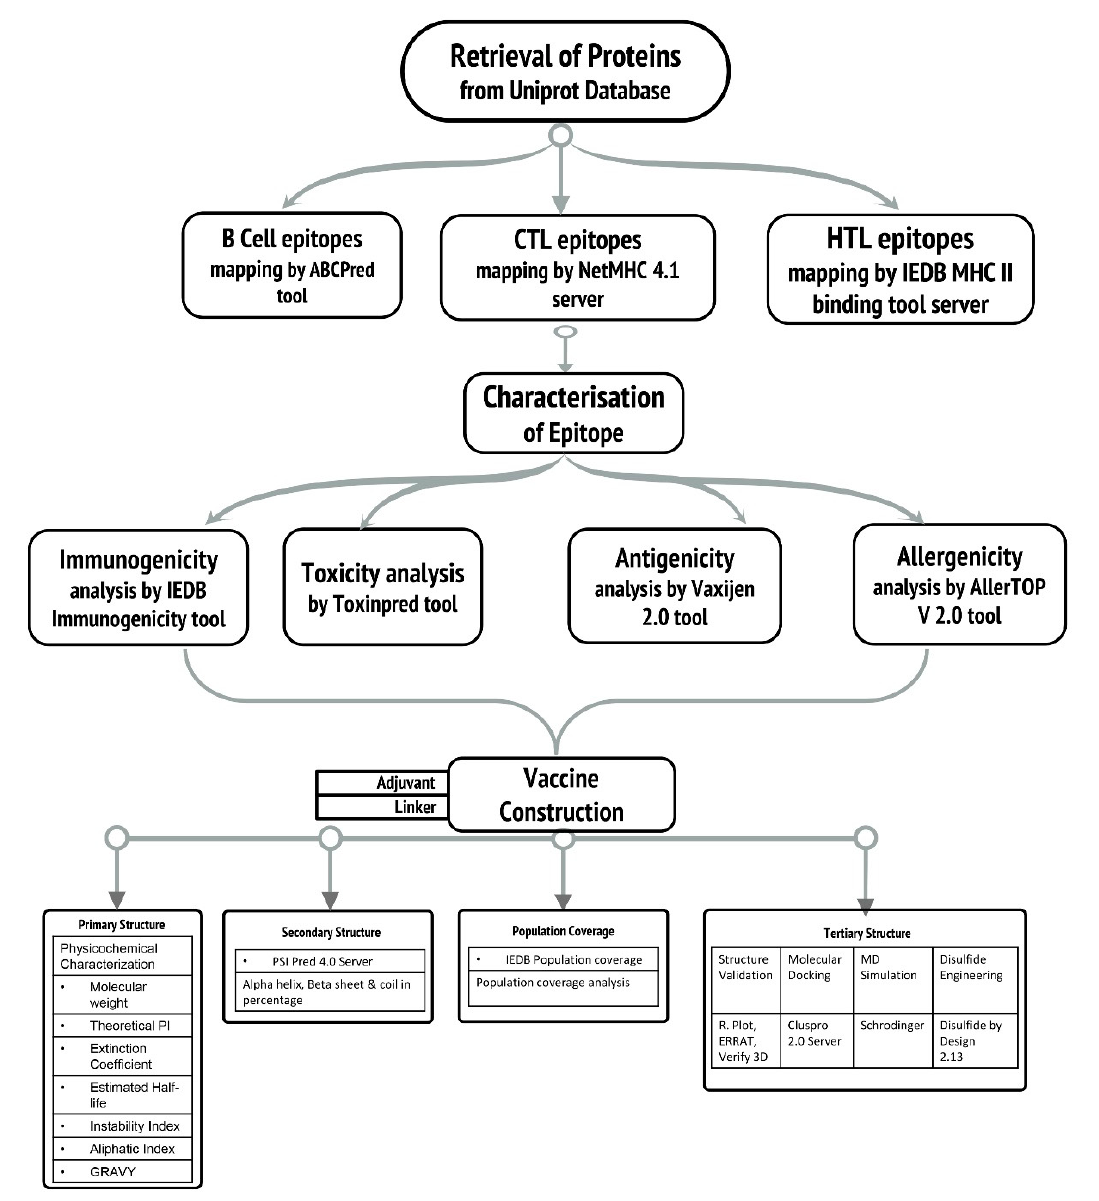
Figure 1. Schematic representation of the workflow for the development of a multi-epitope vaccine against S. aureus infec- tions.